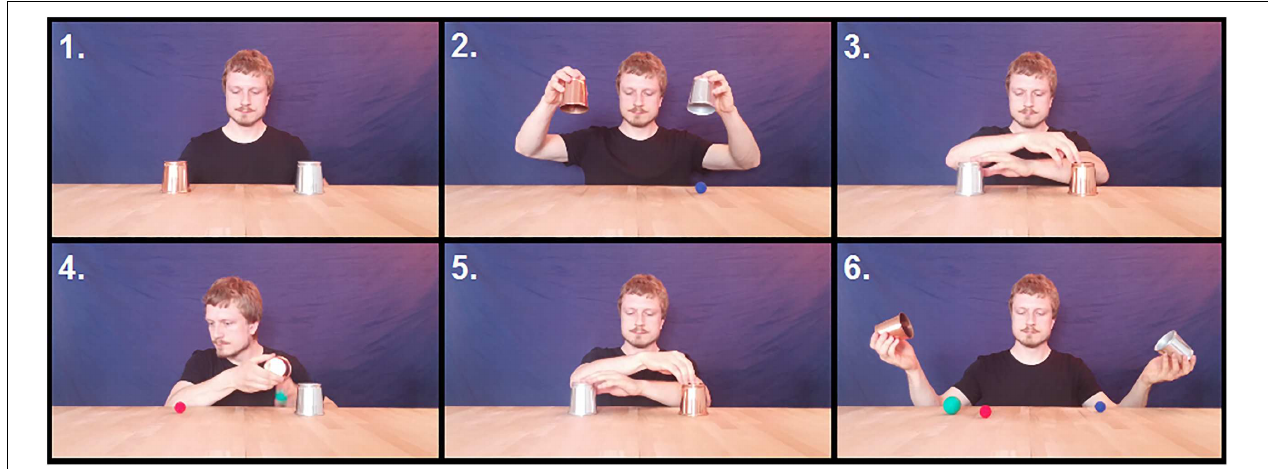
FIGURE 1 | Sequence of events that are part of the choreography presented in the videos. The beginning of the video (1). The blue ball is shown (2). The cups are shuffled (3). The green ball is loaded into the cup (4). The cups are shuffled again (5). The cups are lifted and all balls are revealed (6). All events shown here, except events 4 and 6, are alike in all videos. A depiction of all the different versions of event 4 is shown in Figure 2